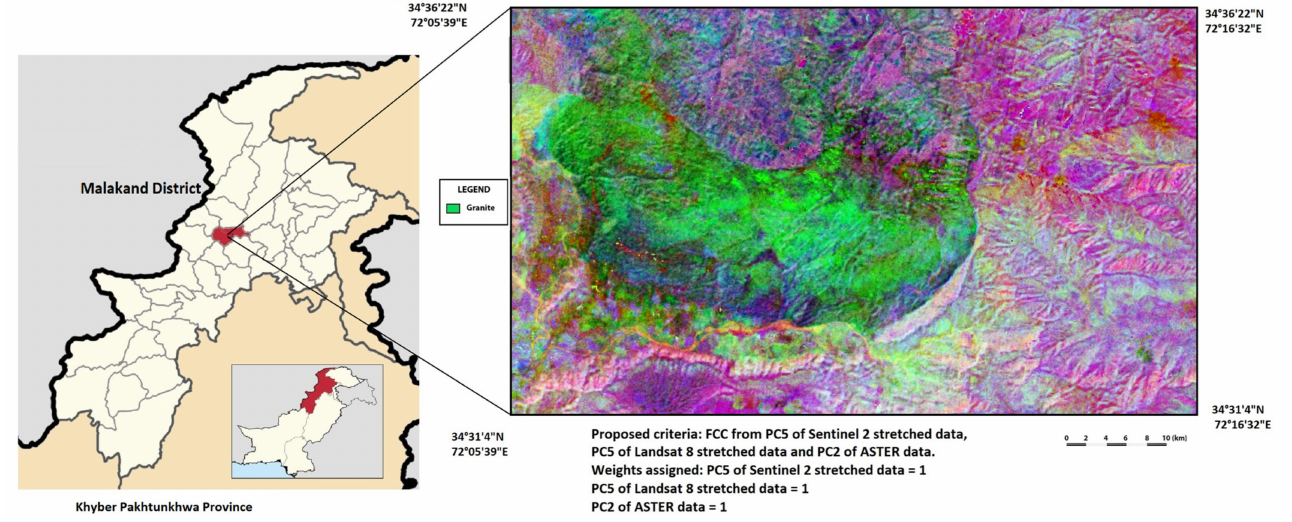
Figure 14. Granite map in the Kotah Dome, Malakand with one component of the stretched Sentinel-2, ASTER, and Landsat-8 data